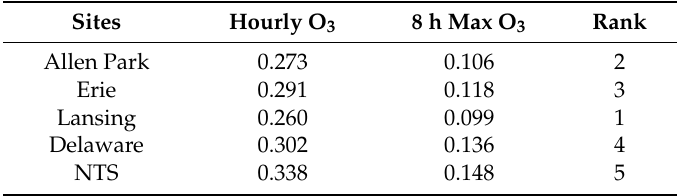
Table 7. Coe ffi cient of divergence (COD) of smog season O 3 concentrations between Windsor and each of the five USA sites during